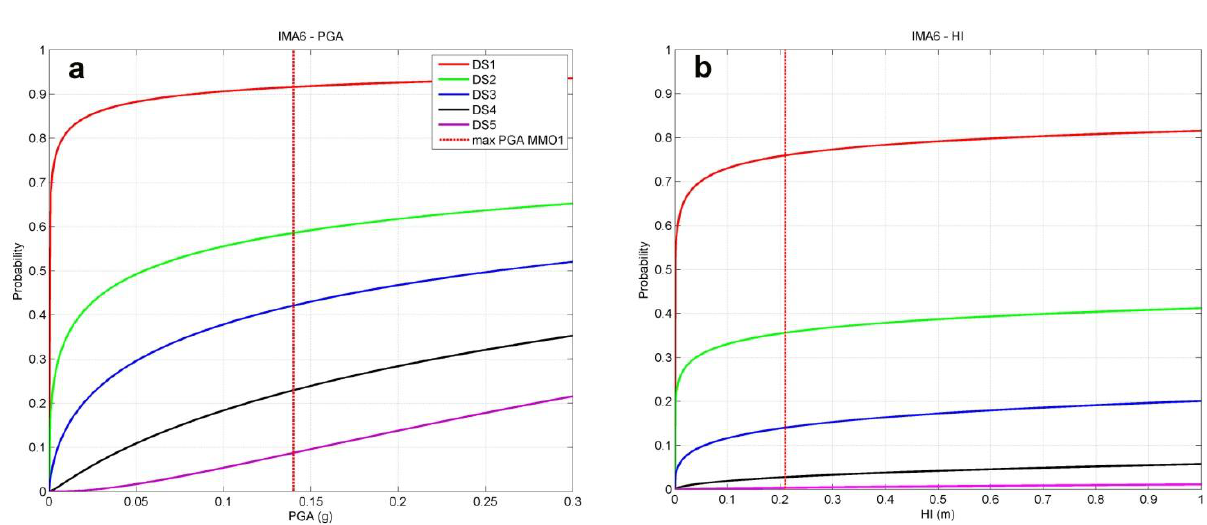
Figure 3. Results for the building of MMO1 station modified by Rota et al [2008]. a) fragility curve in PGA for the typology IMA6. b) fragility curve in HI for the typology